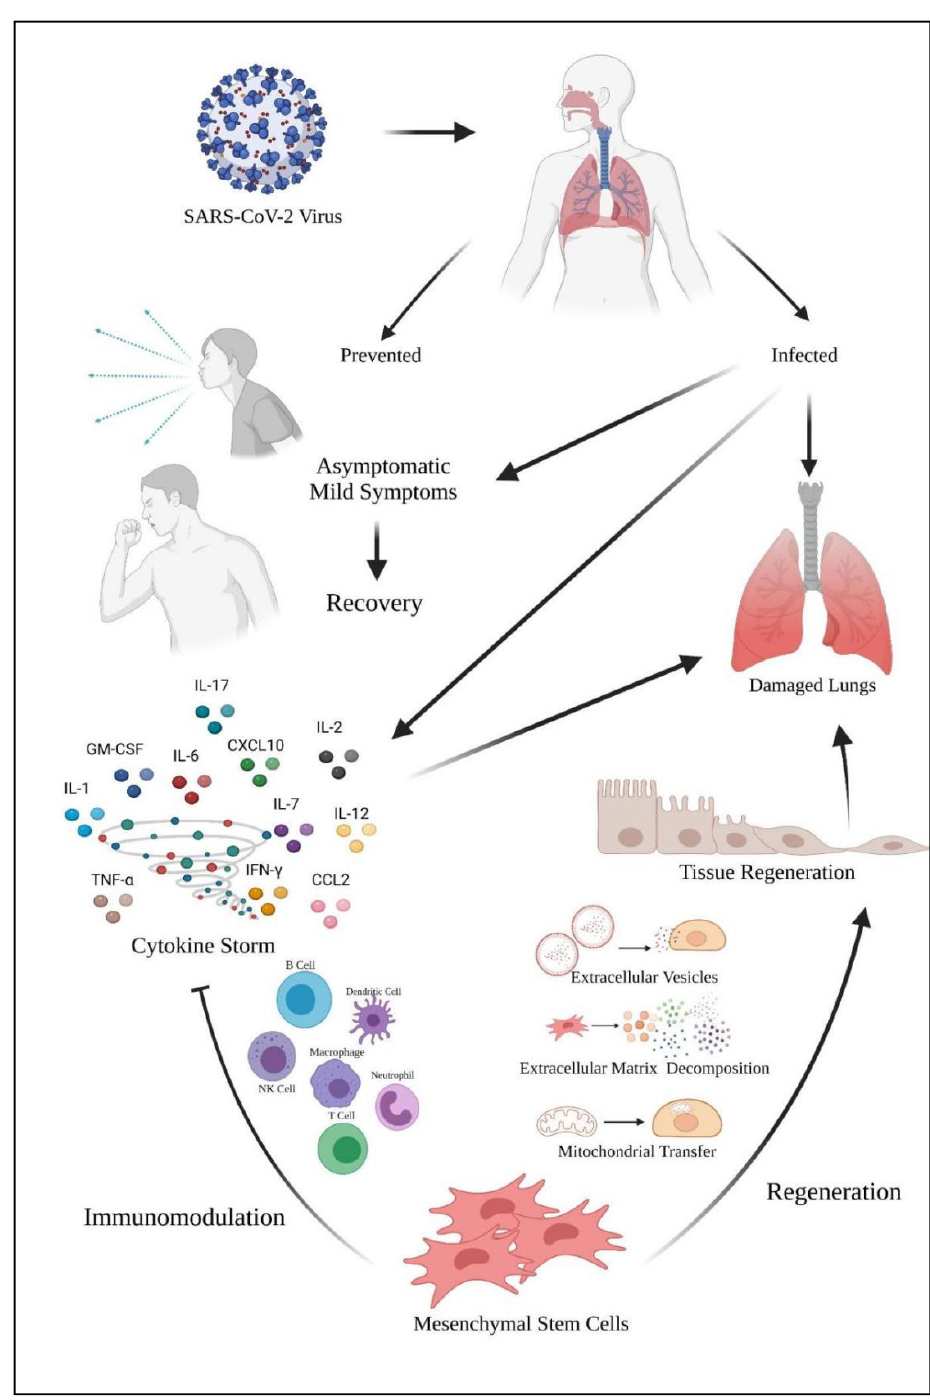
Figure 5. Immunomodulation and regeneration properties of mesenchymal stem cells in coping with cytokine storm caused by SARS-CoV-2 virus. Arrow represents the causes of the SARS-CoV-2 virus to the host’s lung damage and the promotion of regenerative mechanism by mesenchymal stem cells in repairing the lung. The blunt end arrow represents the inhibition of cytokine storm via various leukocytes by mesenchymal stem cells.